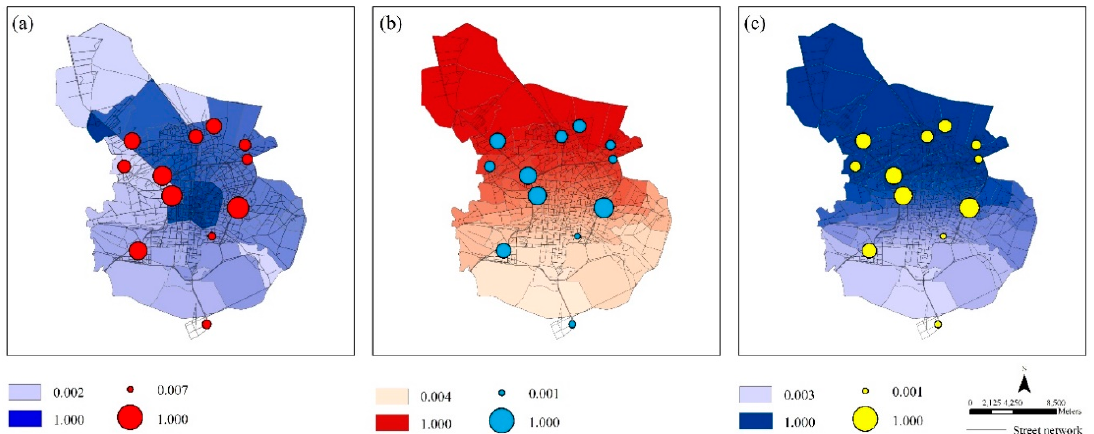
Figure 2. Accessibility of markets and traffic analysis zones (TAZs) (normalized values). ( a ) Accessibility with normal reliable space-time prism (NRNTP). ( b ) Accessibility with exponential non-normal reliable space-time prism (NNRNTP). ( c ) Accessibility with log-normal NNRNTP.